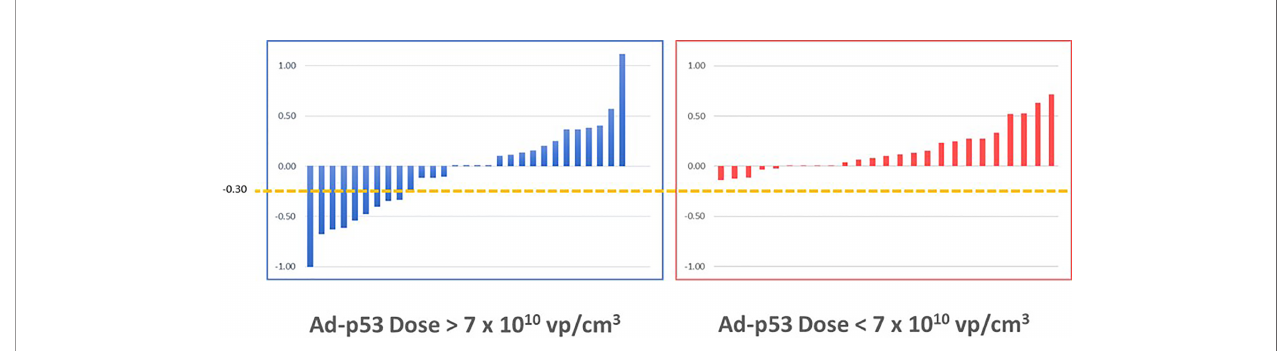
FIGURE 1 | Waterfall plot of percent change in tumor size of target lesions following treatment with Ad-p53. All tumor lesion responses by RECIST 1.1 (reduction of at least 30%) occurred in patients Ad-p53 doses greater than 7 × 10 10 viral particles/cm 3 of tumor